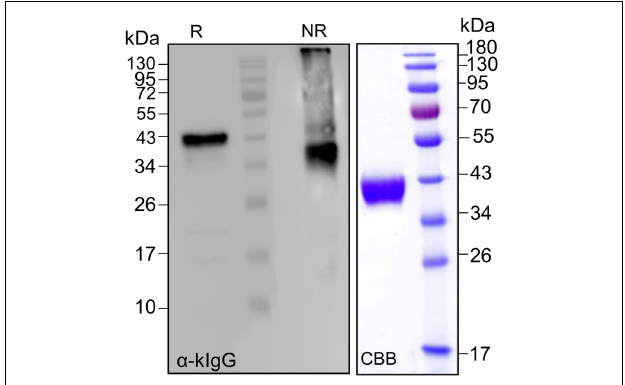
FIGURE 6 | Analysis of the expression of EPO-CL fusions. Total soluble proteins extracted from N. benthamiana (cid:49) XTFT leaves expressing EPO-CL were analyzed with anti-kappa IgG antibodies (light chain) under reducing and non-reducing conditions. EPO-CL purified out of TSP with kappa-select resin was stained with Coomassie Brilliant Blue under reducing conditions (CBB). Protein size markers are shown in kilo Dalton